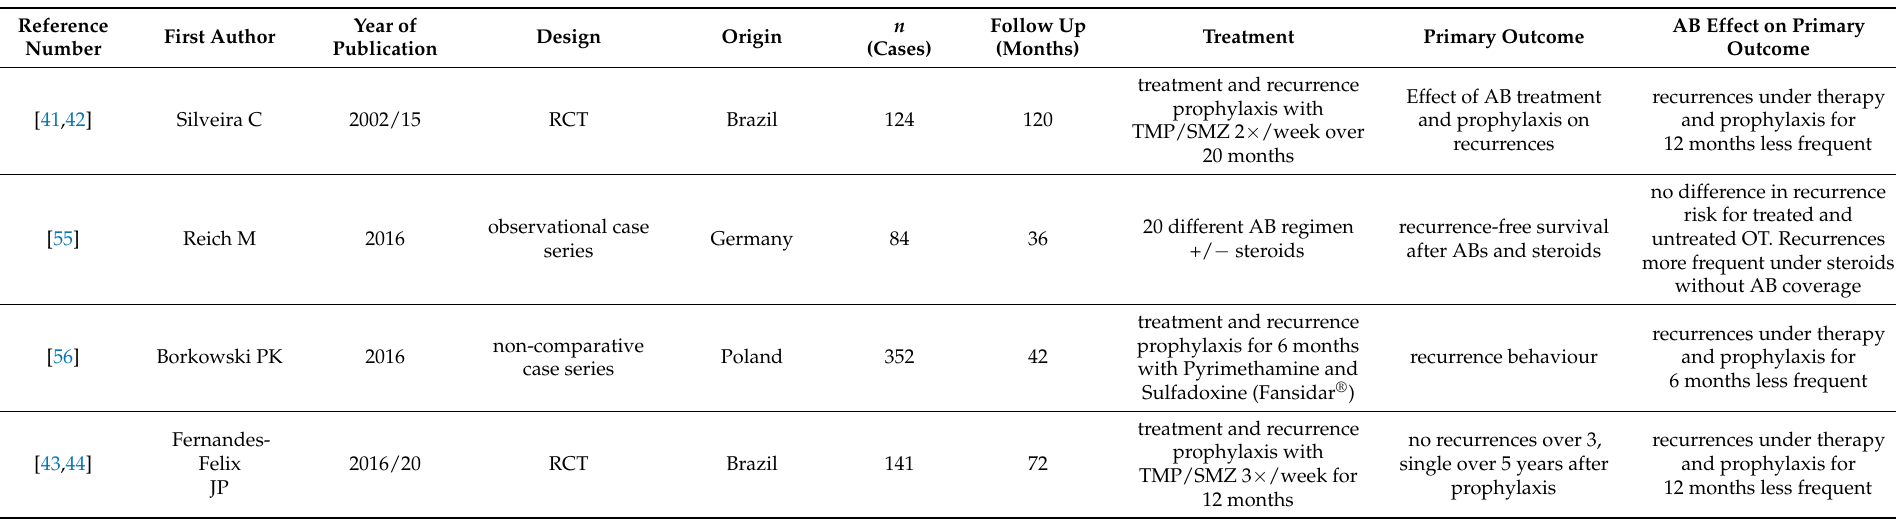
Table 4. Prophylaxis of OT recurrences. Prophylactic protocol and primary study